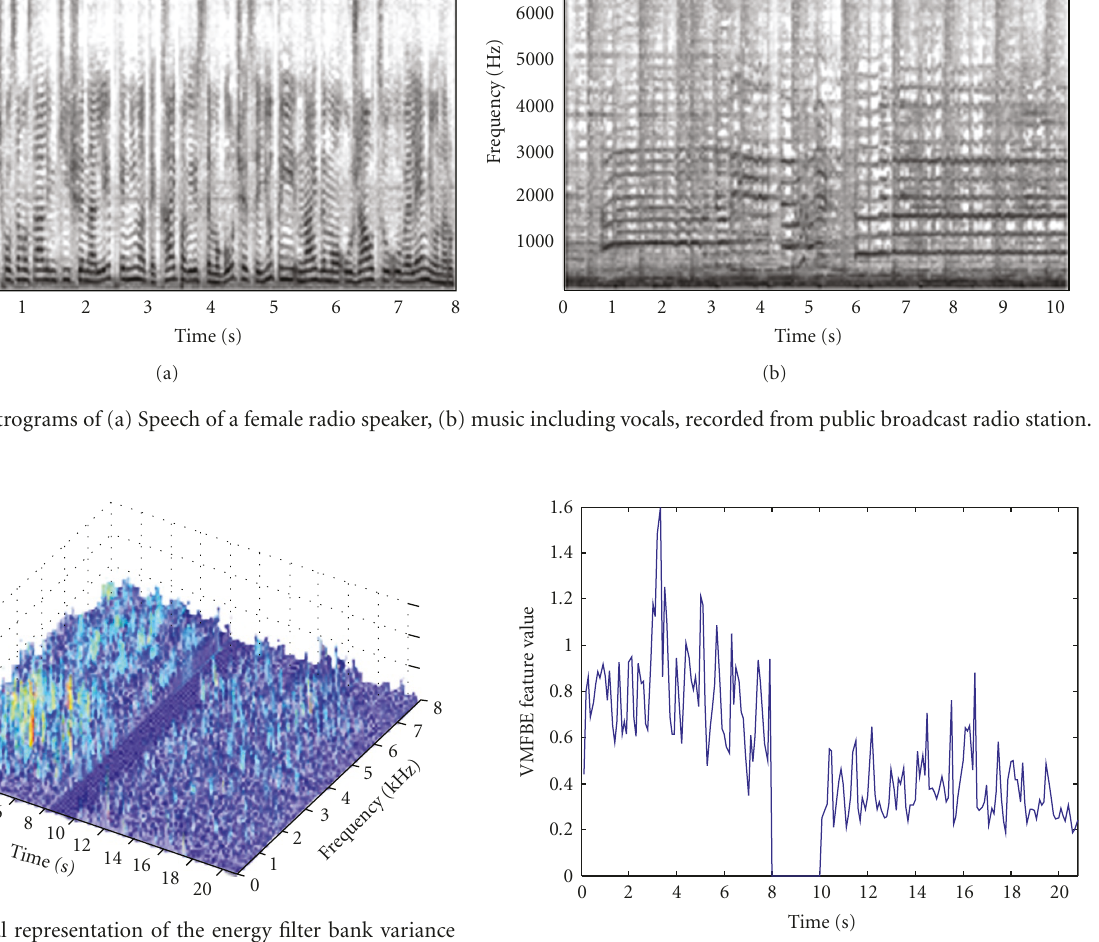
Figure 3: Visual representation of the VMFBE feature (value for speech is higher than for music; 0–8 seconds speech, 8–10 seconds silence, and 10–20 seconds